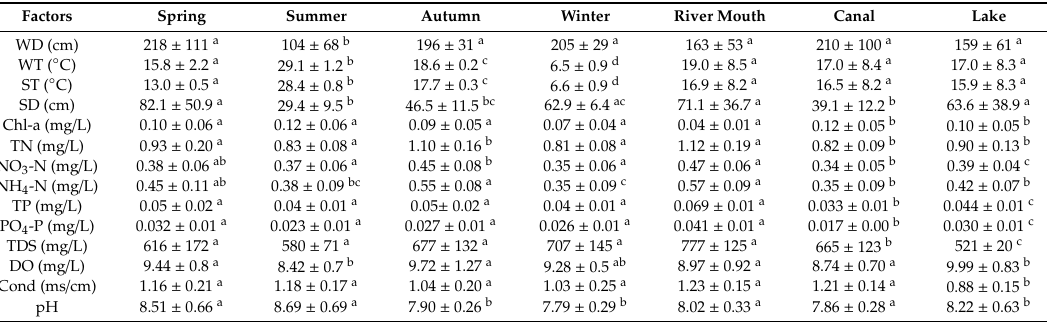
Table A1. The detail of Kruskal-Wallis tests were conducted to detect di ff erences of parameters among seasons and regions.